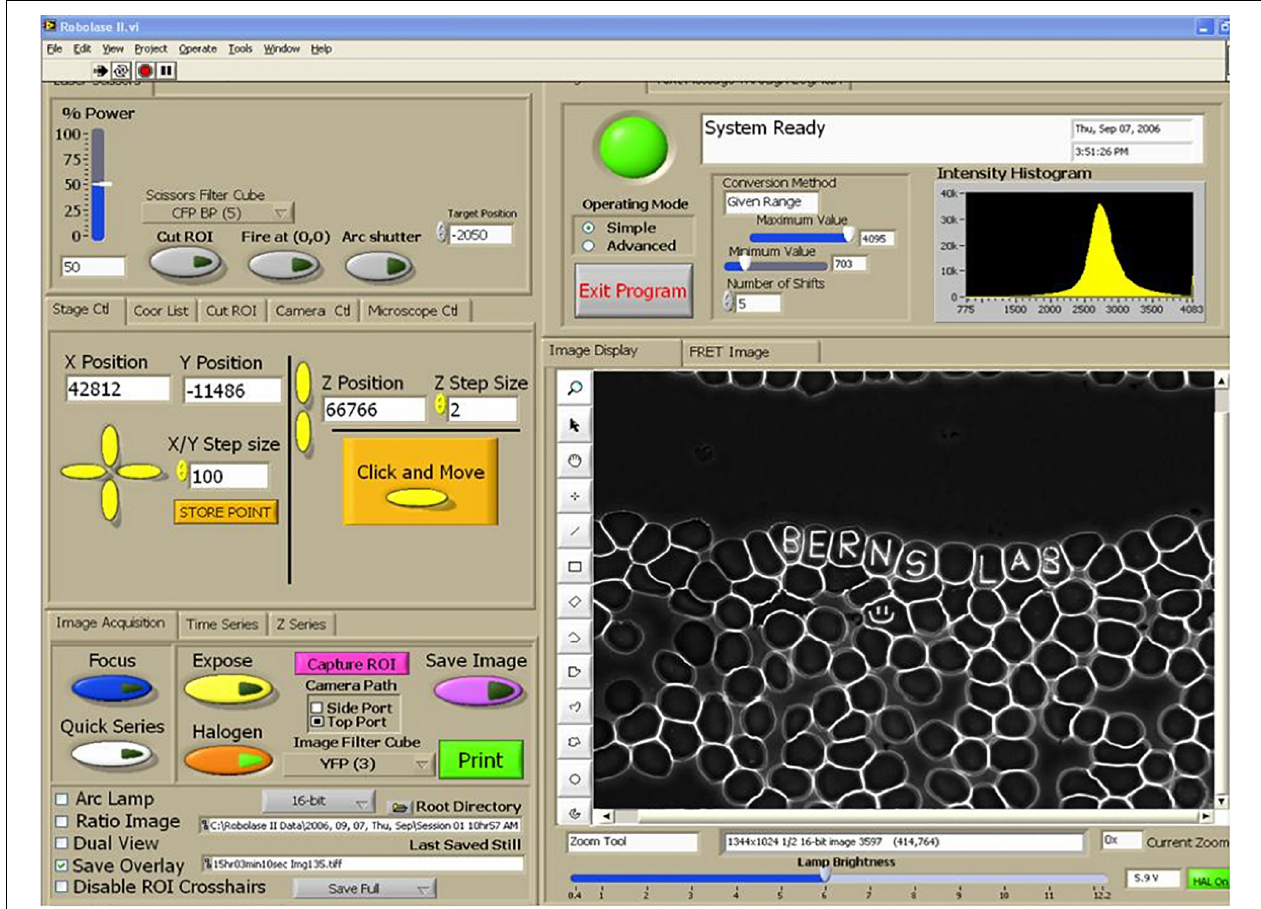
FIGURE 9 | RoboLase control panel for system described in Figure 9 . Air-dried human blood cells are visible in the image panel on the lower right. Name inscrcibed in individul red blood cells (8–10 micron diamter cells) illustrates the precison of the control of the focused laser lesion inside a single cell. Panel on left is used to control laser power delivered, x-y-z movement of the microscope stage, and controls to define the shape/geometry of the exposing laser beam. The control panel can be used in the lab containing the microscope system, or it can be used remotely from a lap-top/computer at another location, including in a foreign country, to conduct an experiment in real time via the internet (Botvinick and Berns,